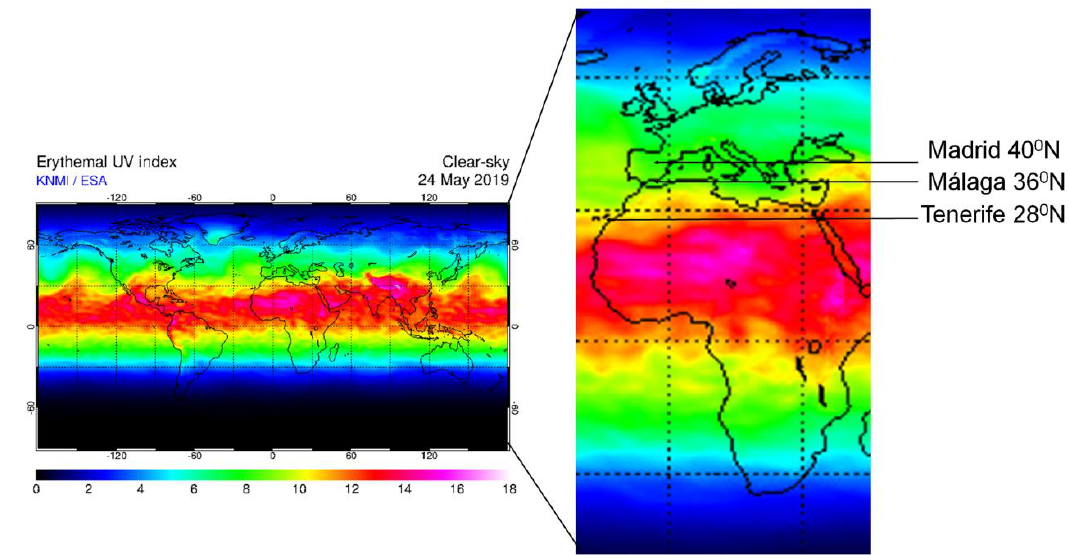
Figure 1. Map of world ultraviolet radiation erythemal index, with the three provinces reported in this study. This index is a measure of ultraviolet radiation (UVR) at ground level on the Earth, being an estimation of the UV levels that have important effects on human skin. Modified from: http://www.temis.nl/uvradiation/UVI/uvief0_wd.gif (accessed 24th of May 2019).